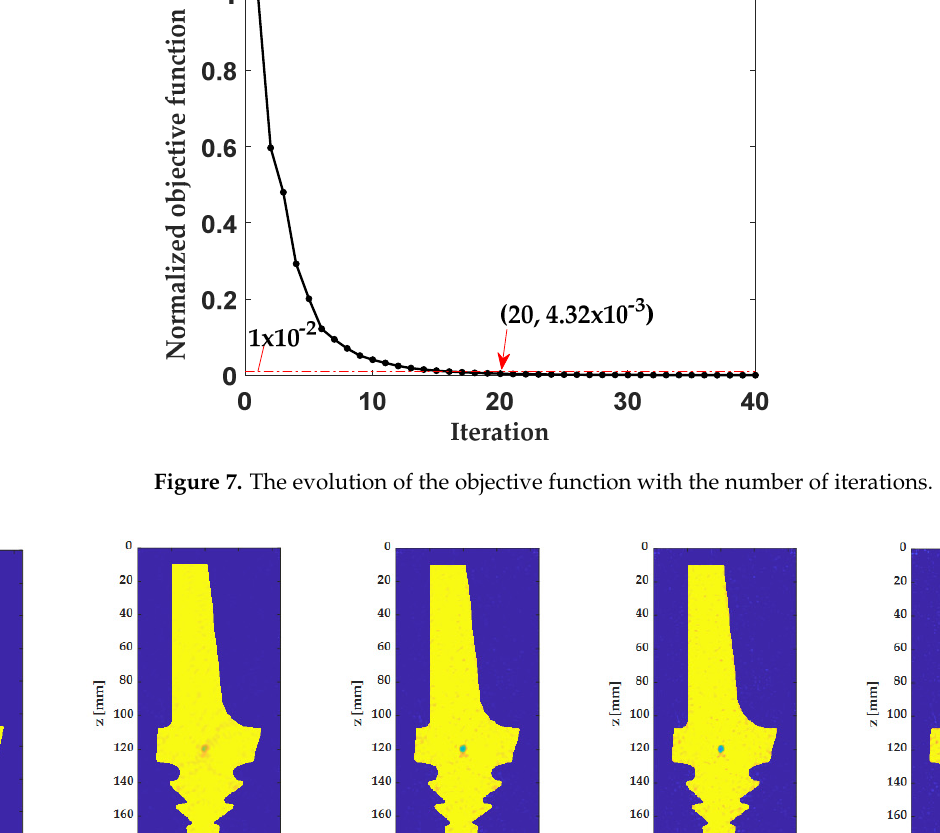
Figure 8. ( a )True model with a 3 mm circular hole and tomographs with different iterations: ( b ) k = 5; ( c ) k = 10; ( d ) k = 20; ( e ) k = 40.